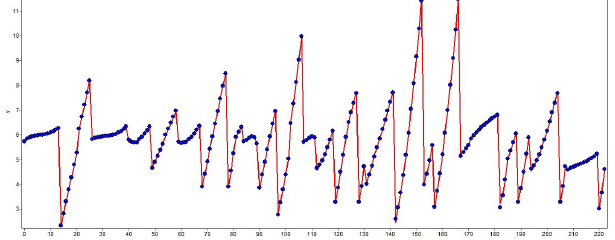
Figure 14. The fitting curve of Eq. (19) ( x 2 ).